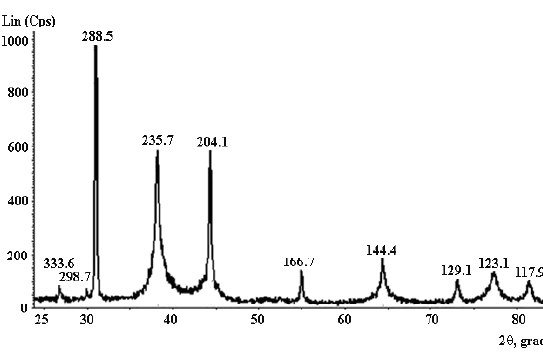
Figure 4. XRD-pattern of substance isolated from Ag- GIM contain- ing «re-precipitated» elemental silver and obtained with